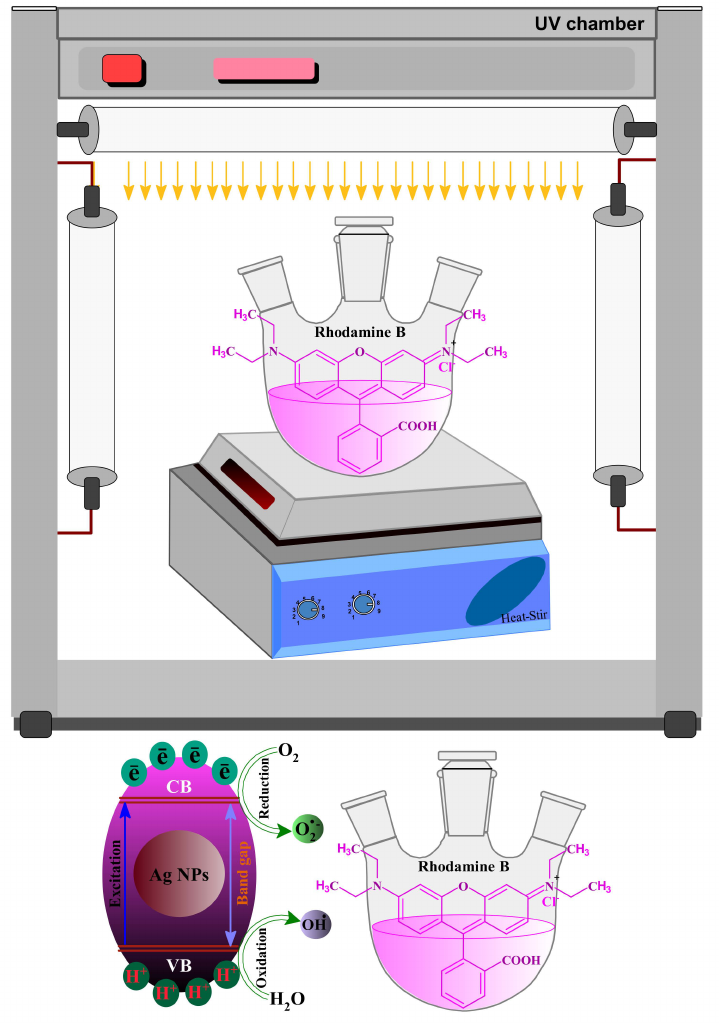
Figure 14. Schematic diagram showing the plausible mechanism for the degradation of RB over biomolecule-capped AgNPs under UV light irradiation.